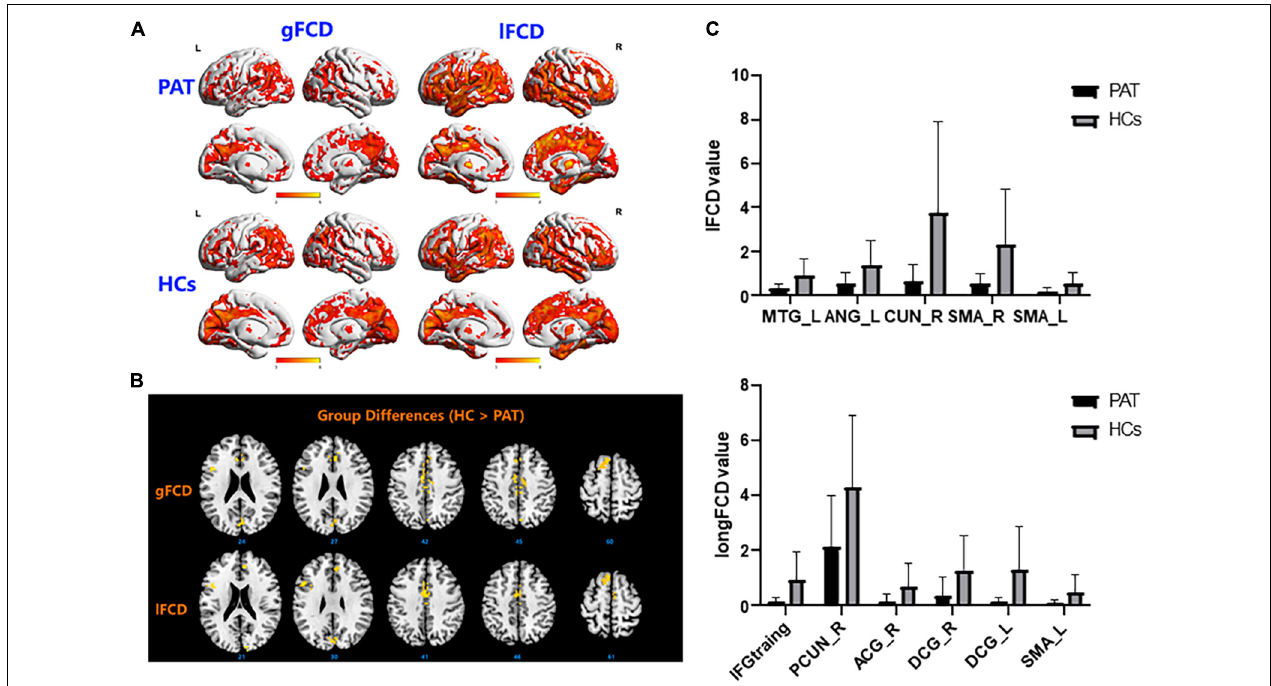
FIGURE 1 | (A) Binarized longFCD (left) and IFCD (right) values in different brain regions. (B) Binarized longFCD and IFCD differences between the HC and ON groups. Yellow areas show lower values in ON groups. (C) Significant IFCD differences were observed in the left middle temporal gyrus/angular gyrus/supplementary motor area/right cuneus/supplementary motor area. Significant longFCD differences were observed in the left inferior frontal gyrus, triangular part/right precuneus/right anterior cingulate, paracingulate gyri/median cingulate, paracingulate gyri/left median cingulate, and paracingulate gyri/supplementary motor area. longFCD, long-range functional connectivity density; IFCD, short-range functional connectivity density; PAT, patient; HCs, healthy controls; L, left; R, right.